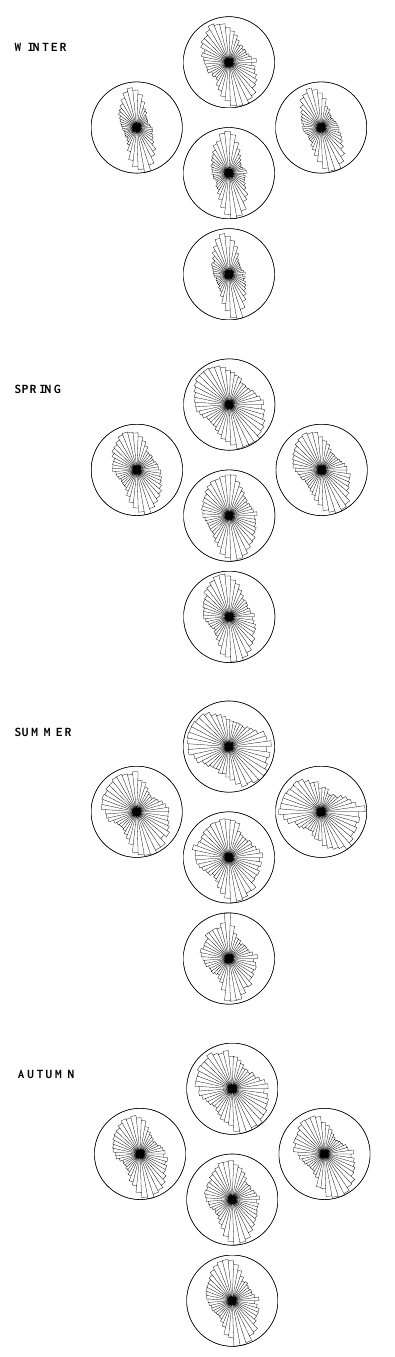
Fig. 10. Directional distributions of dH/dt during the four seasons from 1986 to 1996 at PEL, MUO, KIL, KEV, SOR. Panels from top: winter, spring, summer, autumn. Stations in the middle are SOR (top), MUO, PEL (bottom). KIL is on the left and KEV on the right. The distribution patterns are normalized separately for each